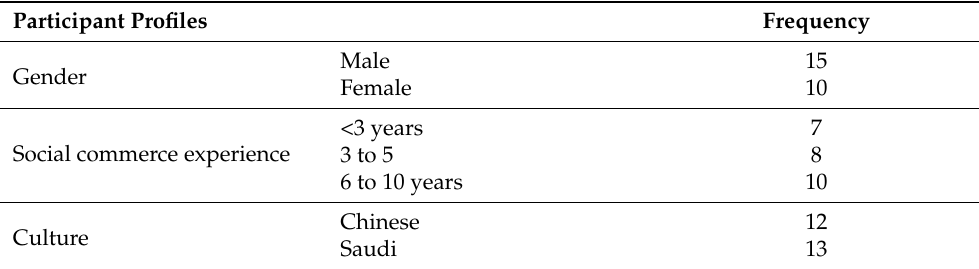
Table 1. Summary of participant